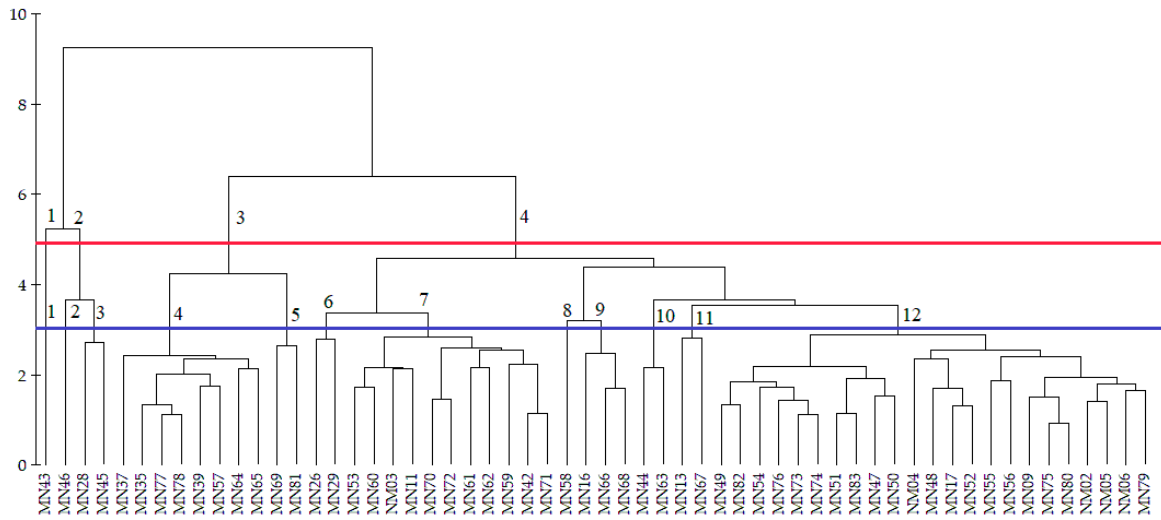
Figure 6. Clustering water quality in the water bodies in Dong Thap province in 2019.